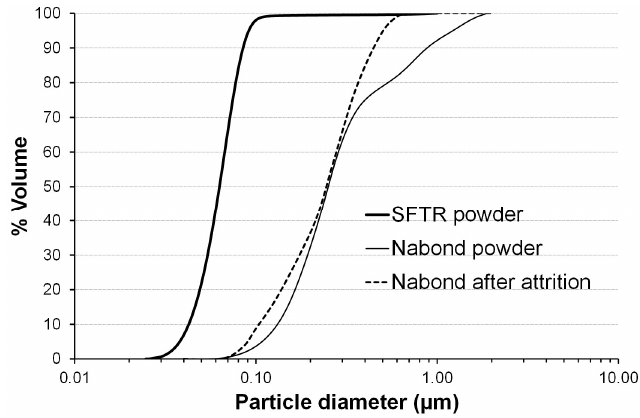
Figure 4. Particle size distribution of ZnO nanopowders synthesized using the SFTR process, and commercial Nabond, as received, and after an attrition treatment.